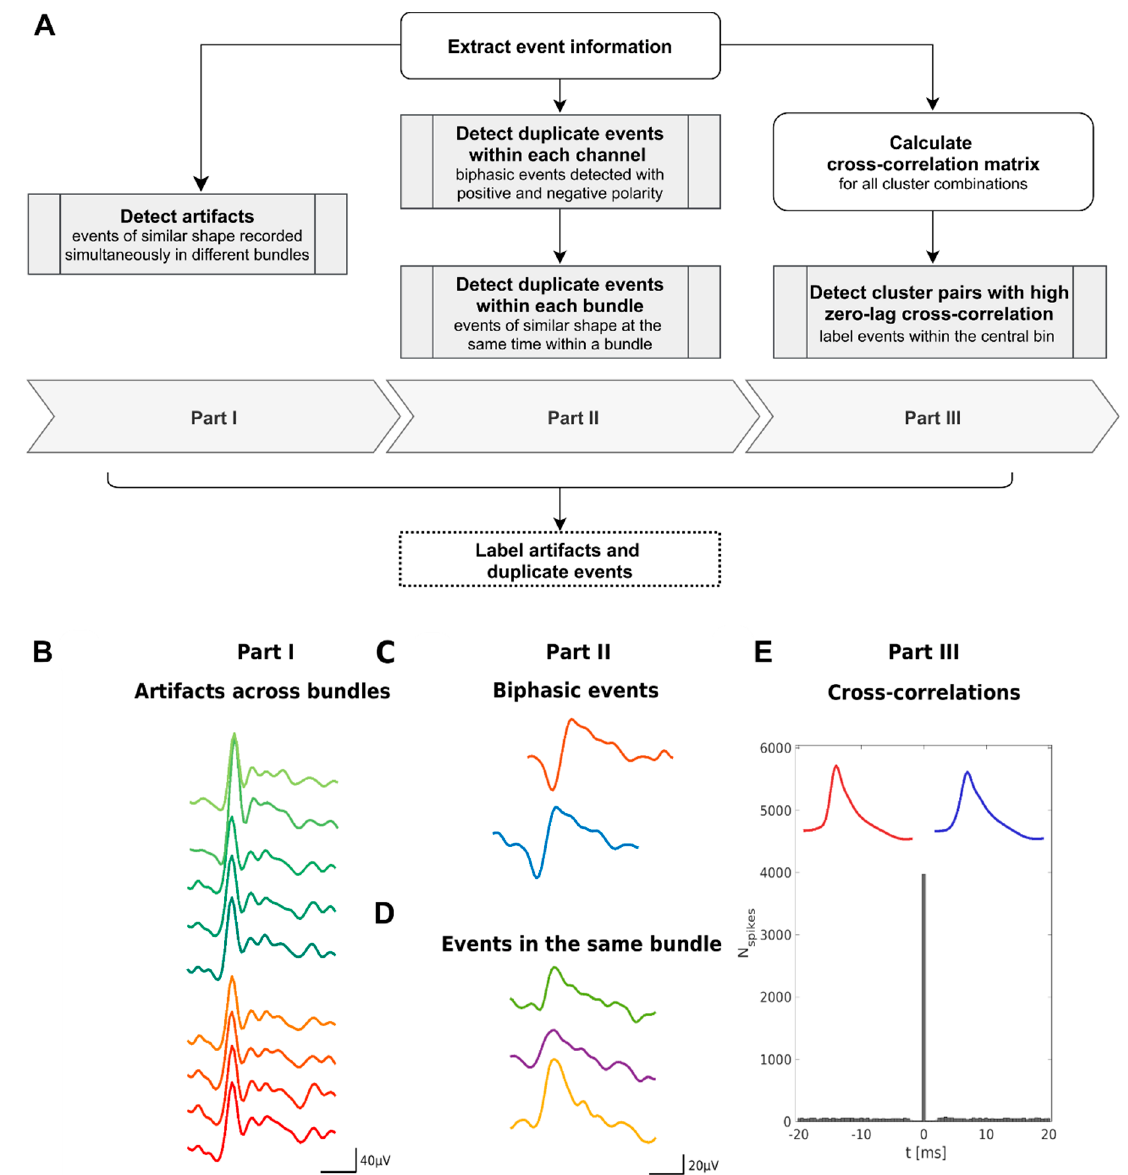
Figure 2. Schematic and illustrative examples for the three parts of the DER algorithm for the detection of spikes events that were recorded or detected multiple times. ( A ) Schematic flow chart of the algorithm. ( B ) In Part I we compare all combinations of the shapes of spike events appearing in a time window of 50 µs on different bundles. An example of event shapes recorded in different bundles is shown (red: left posterior hippocampus (LPH), green: left parahippocampal cortex (LPHC)). ( C , D ) In Part II, we first identify biphasic events that are detected with positive and negative polarity on the same channel within a time window of 650 µs. Panel ( C ) illustrates an example of biphasic event shapes (LPHC 5). Furthermore, similar events within the same wire bundle are identified if they appear within a time window of 50 µs and have highly similar shapes (example in ( D ) from LPHC). In Part III cross-correlograms are calculated for each combination of two clusters. If the central bin exceeds a certain threshold, the spike events within the central bin are considered to be duplicate. Subfigure ( E ) shows an example of the cross-correlograms of two single units that were recorded on two different microwires in the left amygdala. Both units have a large fraction of simultaneous spikes and a similar mean spike shape (shown in red and blue). For each part of our algorithm, we define criteria to determine which event to retain and which to label as artifacts (see also Tables 2 and 3).